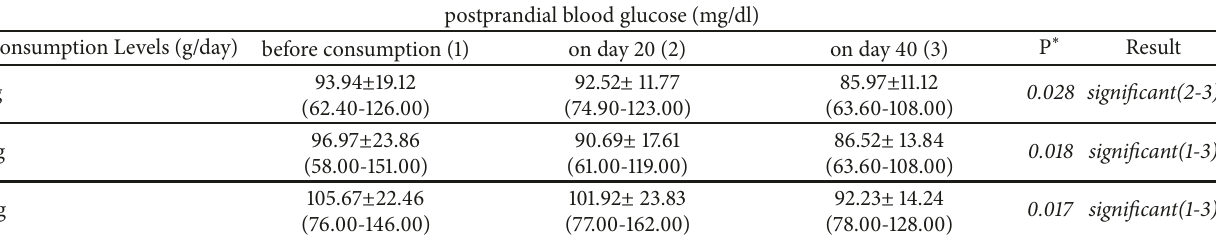
Table 4: Effect of cinnamon on postprandial blood glucose